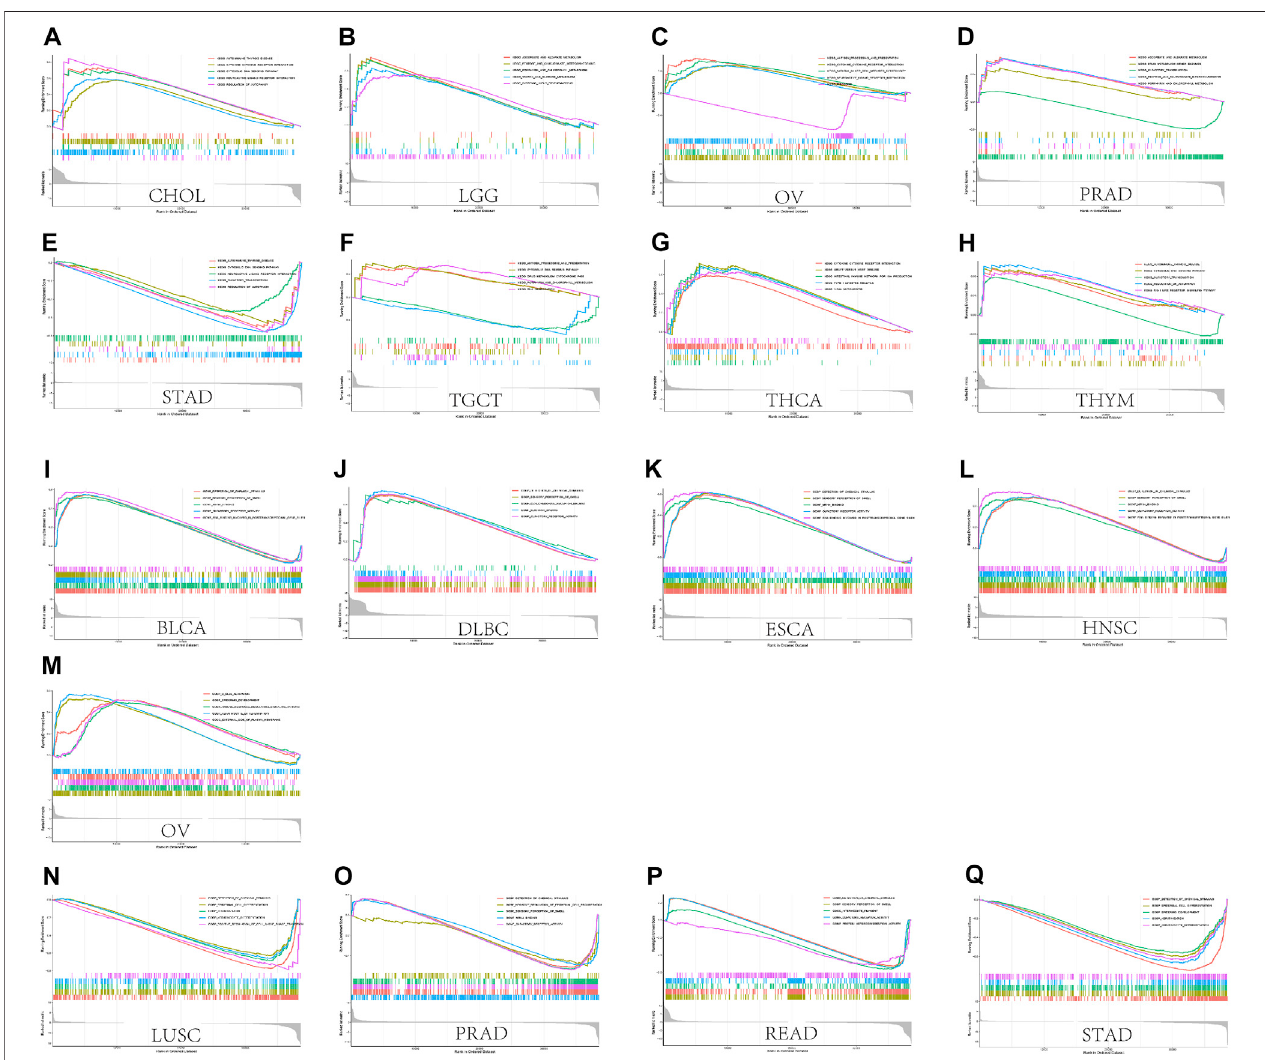
FIGURE 11 | GSEA results. (A) Results of KEGG enrichment analysis of CASP3 in multiple tumours. (B) GO enrichment analysis of CASP3 in multiple tumours. Curves of different colours show different functions or pathways regulated in different cancers. Peaks on the upward curve indicate positive regulation and peaks on the downward curve indicate negative